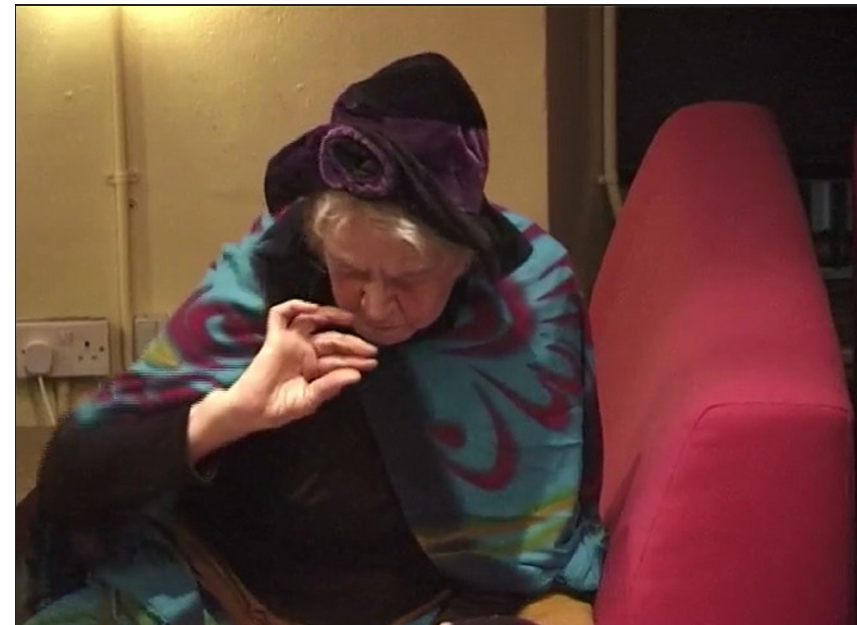
Figure 2.1: (48.45) Jennifer Pike with Birdyak at the RCA, London 2002. Courtesy of William